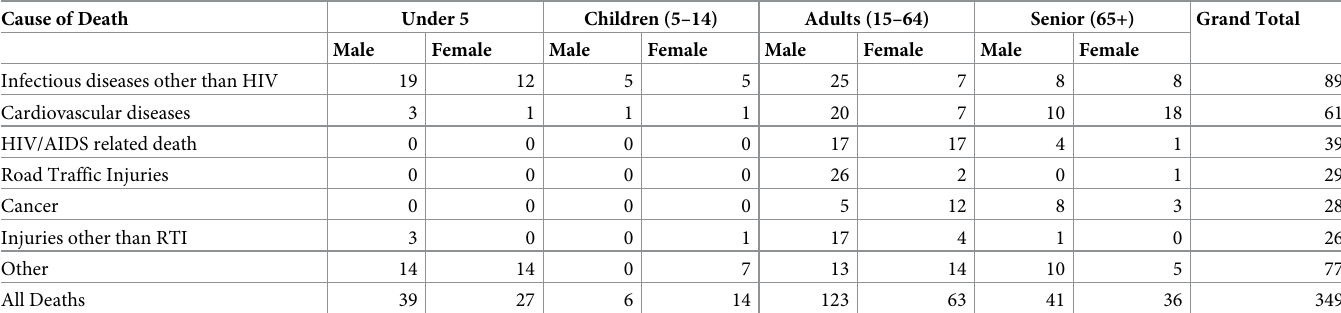
Table 2. Number of deaths by age group, sex and cause of death.